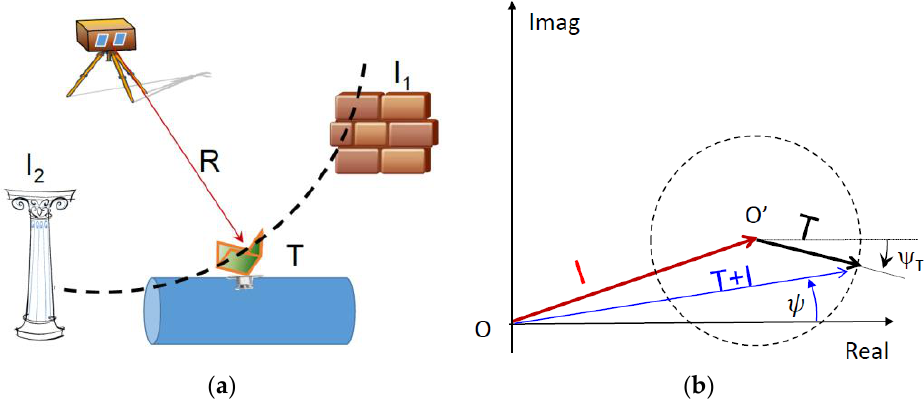
Figure 5. Model ( a ) and impact ( b ) of clutter interferences with Radar measures.